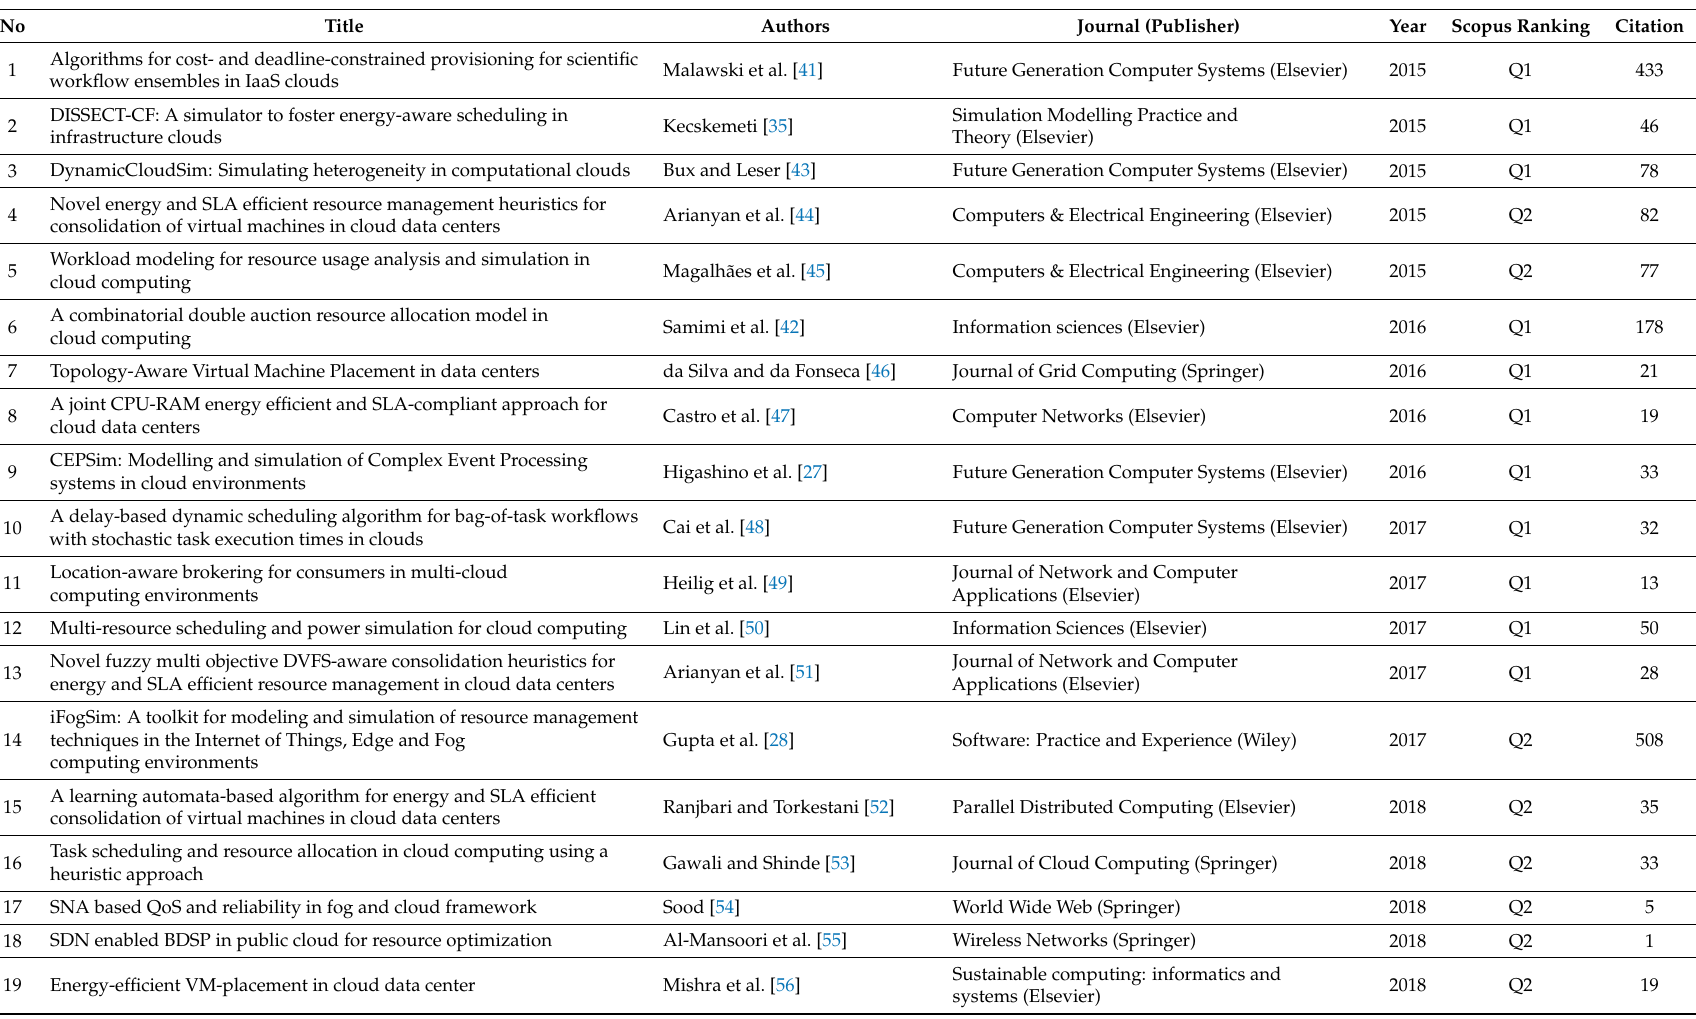
Table 2. Final selection of